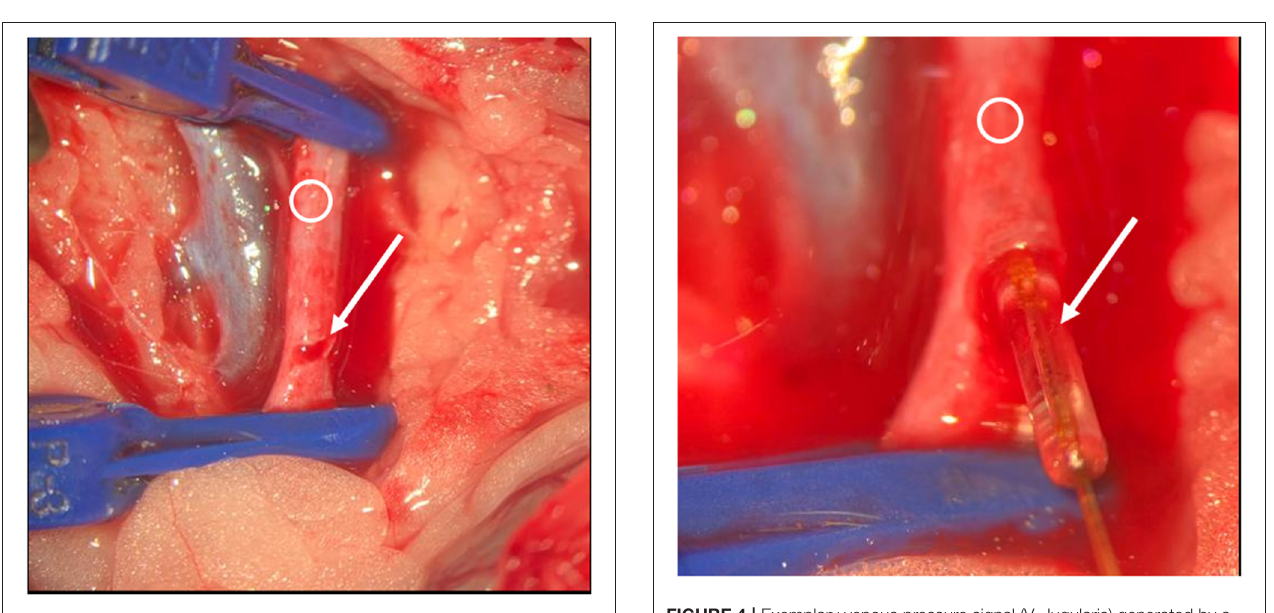
Measured intraluminal mean maximum arterial amplitude was 13.6 mmHg SD 1.9; mean venous amplitude was 5.2 mmHg SD 3.3 ( Table 1 ), with a ratio of